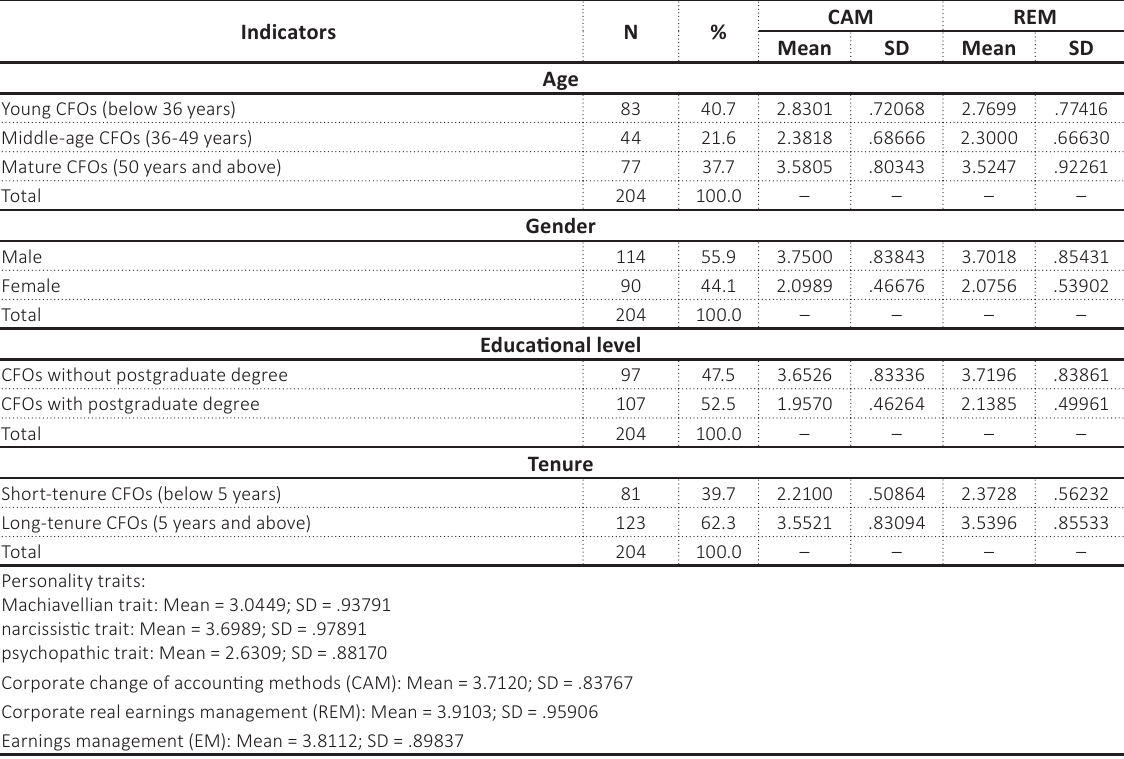
Table 1. Descriptive statistics